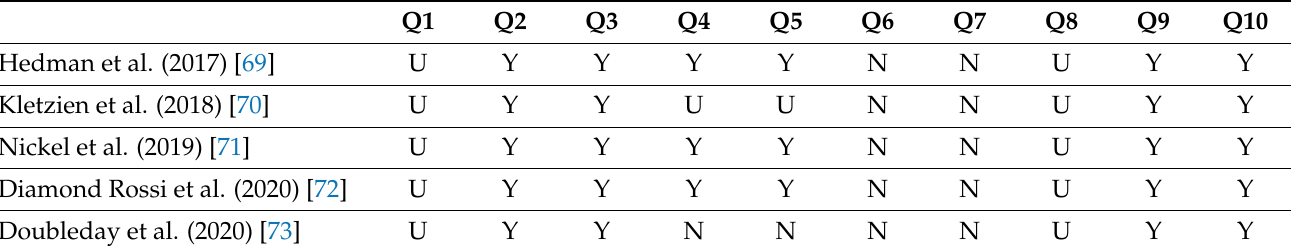
Table 4. Quality assessment of mixed-methods or qualitative